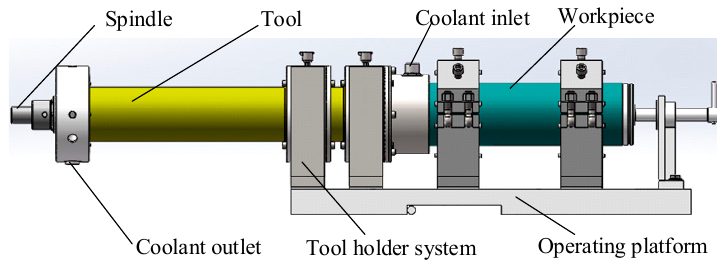
Figure 1. BTA deep-hole trepanning machine tool.